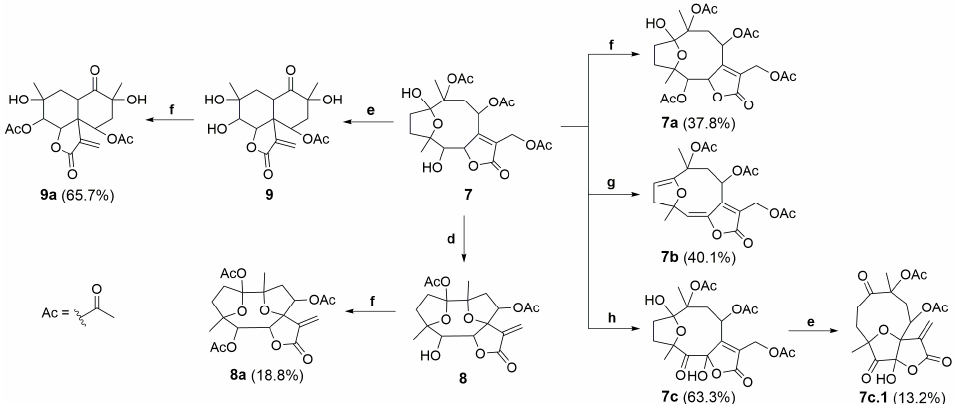
Figure 7. Conditions for the chemical transformations of compounds 7a – 9a . Reaction conditions: ( d ) K 2 CO 3 (aq.), THF, reflux at 45 °C, 2 h; ( e ) BiCl 3 , CH 2 Cl 2 , reflux at 50 °C, 15 h; ( f ) DMAP, Et 3 N, Ac 2 O, CH 2 Cl 2 , − 10 °C, 0.5 h; ( g ) SOCl 2 , pyridine, Ar, CH 2 Cl 2 , − 10 °C (0.5 h) to reflux at 60 °C (3.5 h); and ( h ) PCC/SiO 2 (1:1), CH 2 Cl 2 , Ar, rt, 48 h. Percentage of reaction yield in parentheses.